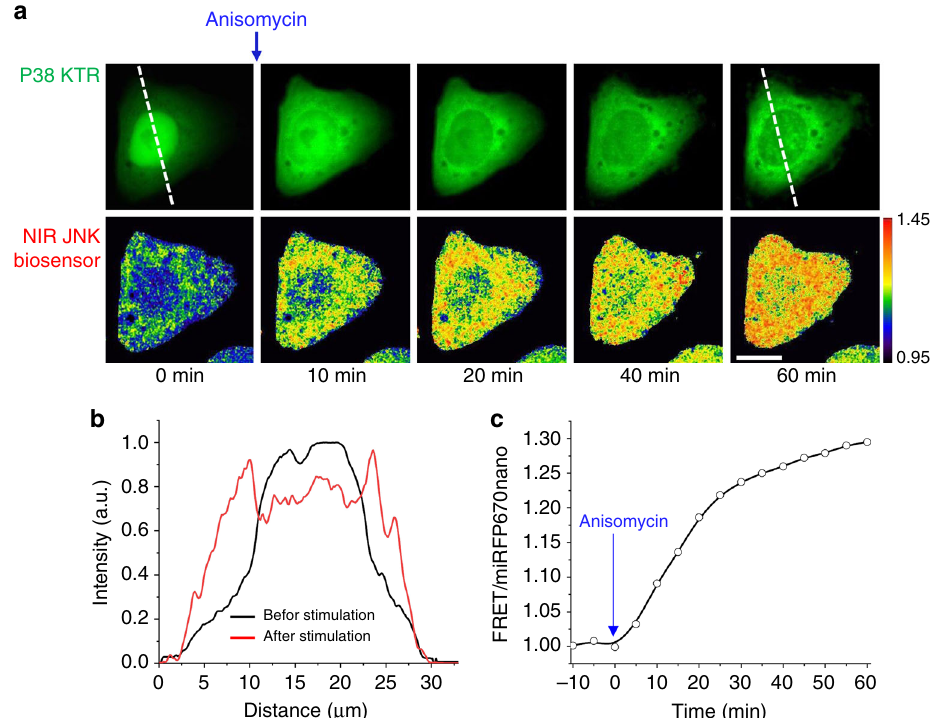
Fig. 6 HeLa cell stably expressing NIR JNK biosensor co-transfected with p38 kinase translocation reporter (p38 KTR). a p38 KTR-EGFP translocation (top row) and FRET/miRFP670nano ratio changes (bottom row) upon stimulation with 1 μ g ml − 1 anisomycin. Dashed line marks the region used for pro fi